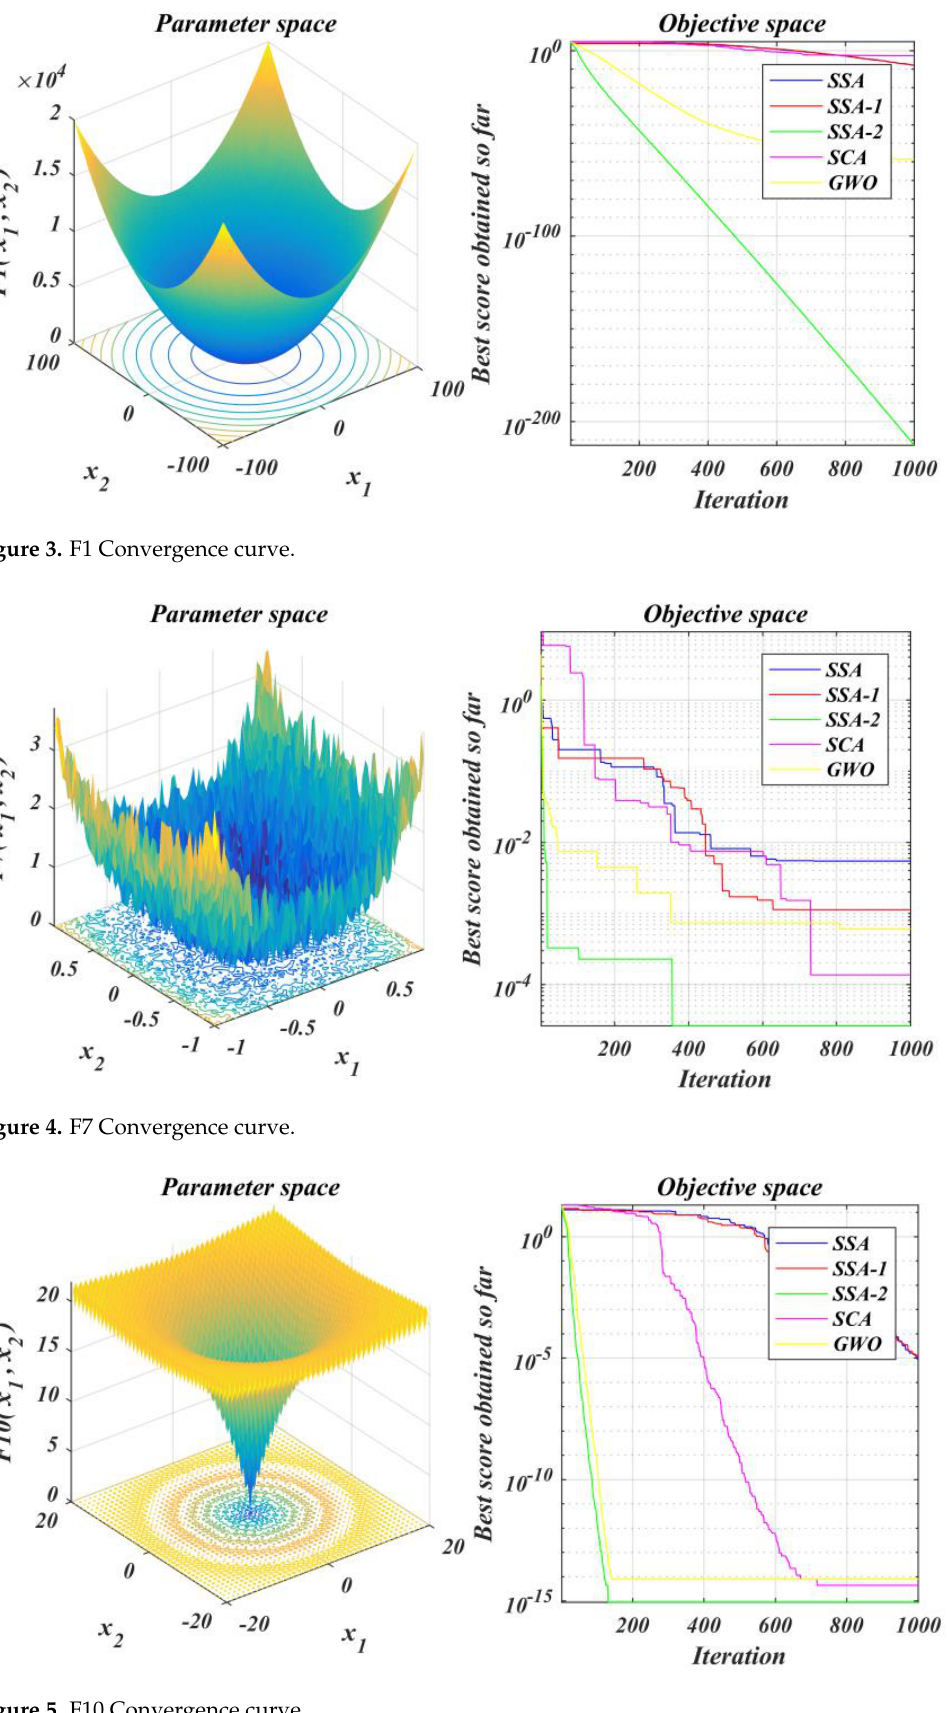
Figure 6. F13 Convergence curve. Figure 7. F14 Convergence curve.